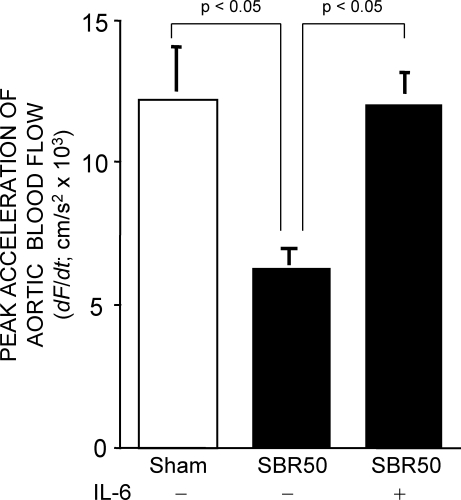
Effect of trauma/HS without or with IL-6 on peak acceleration of aortic blood flow.Rats were subjected to the sham or the SBR50 protocol; SBR50 rats were randomly assigned to receive either placebo or IL-6 at the start of resuscitation (n≥3 in each group). Sixty minutes after start of resuscitation or at the equivalent time point for shams, rats underwent Doppler studies of the ascending aorta. Data presented is the mean±SEM of peak acceleration of aortic blood flow; significant differences are indicated (one-way ANOVA followed by Student-Newman-Kuels test).